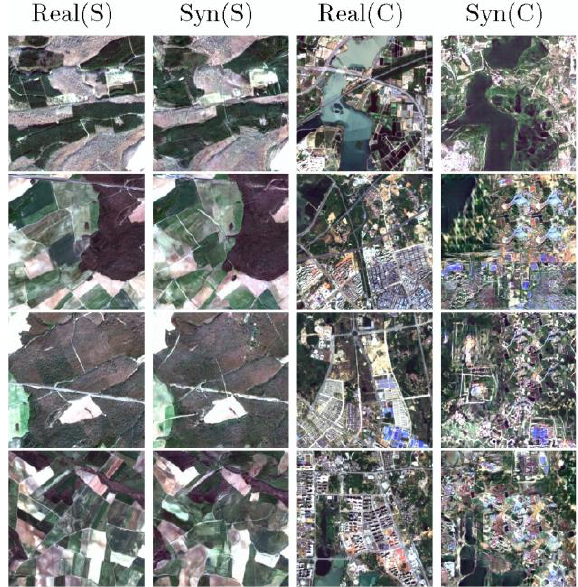
Figure 1. SAR-to-optical image synthesis using Pix2Pix [10] under simple and complicated scenarios. The real optical images and the images synthesized by Pix2Pix are presented in adjacent columns. The first two columns show the performance of Pix2Pix under a simple scenario, and the next two columns show its performance under a complicated scenario. The image resolution is 10 m.